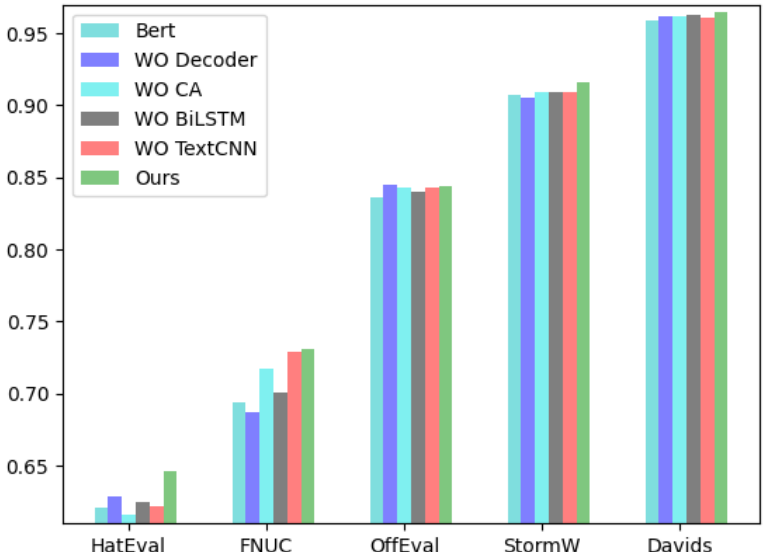
Figure 4. Weighted F1 results for the ablation study. We removed different components from model separately, such as decode, CA, BiLSTM, TextCNN. The results show that removing any component has a negative impact on model performance.